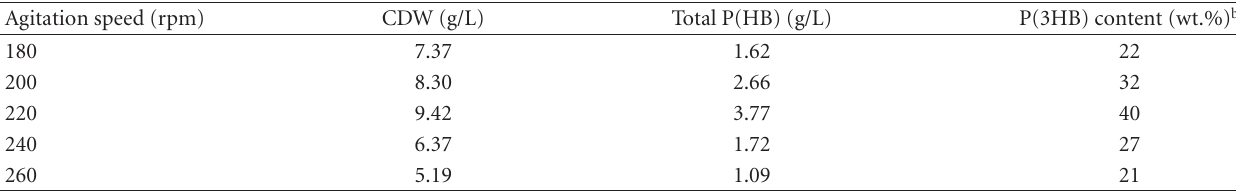
Table 2: E ff ect of agitation speed on the biosynthesis of P(3HB) a .